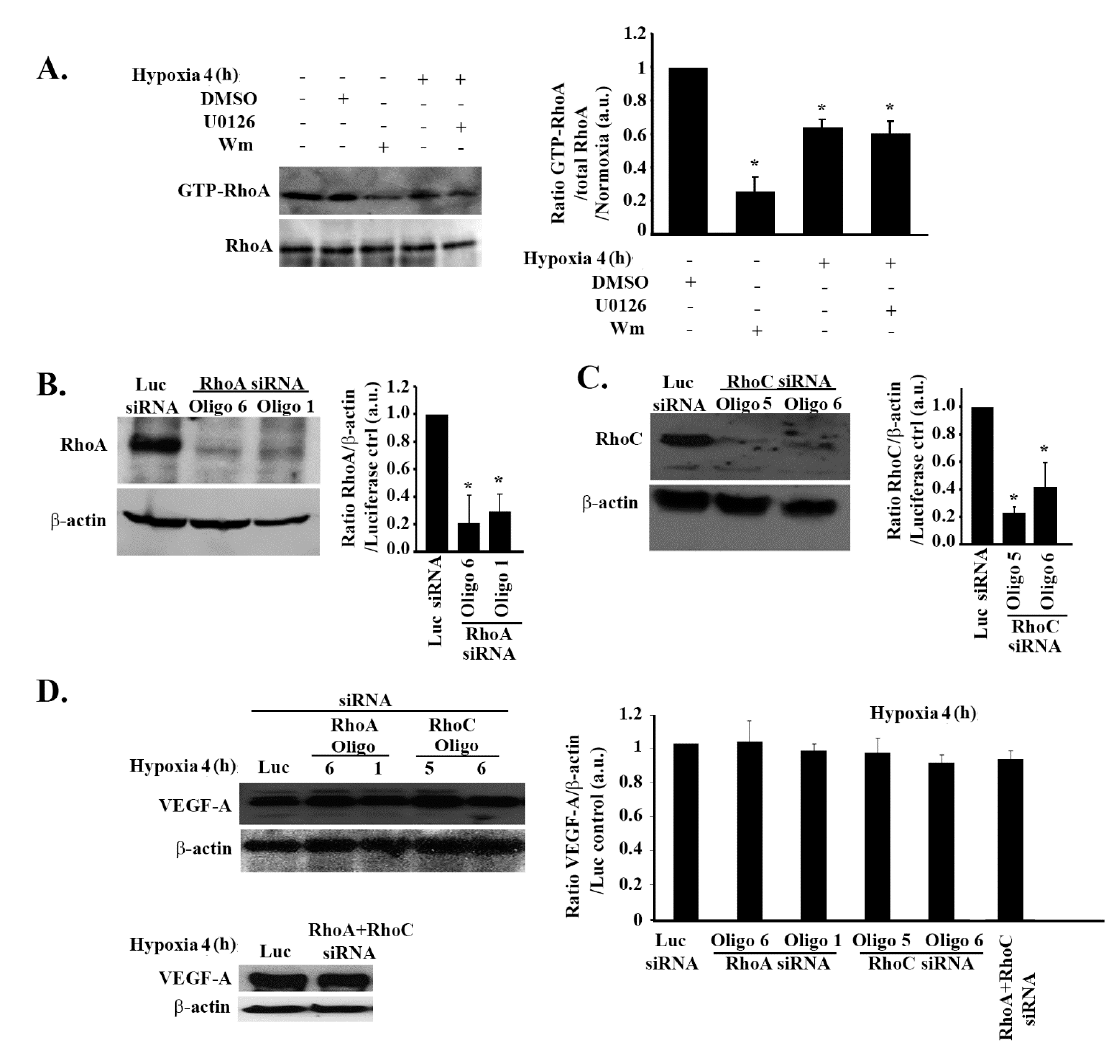
Figure 3. Hypoxia-induced increase in VEGF expression is independent of RhoA and RhoC in glioblastoma cells. ( A ) ( + indicates addition of the treatment) SF-268 cells were treated with DMSO alone or U0126 or Wm, subjected to hypoxia for 4 h, or left in normoxia and lysed. The lysates were then subjected to a RhoA pull-down assay. The upper gel shows the active (GTP-loaded) RhoA that was pulled down with the GST-RBD beads blotted with anti-RhoA, and the lower gel shows the total lysates blotted for anti-RhoA for loading control. The graph is a quantitation of the bands in the upper gel normalized to total RhoA and expressed as fold change compared to time zero (normoxia). (B / C) SF-268 cells were transfected with luciferase siRNA for control of with two RhoA small interfering RNA (siRNA) oligos (oligos 6 and 1) ( B ) or two RhoC siRNA oligos (oligos 5 and 6) ( C ) for 72 h. Cells were then lysed, and cell lysates were blotted for RhoA or β -actin for loading control ( B ) or RhoC and β -actin ( C ). The graphs are quantitations of the bands in (B / C) normalized to actin and expressed as fold change compared to luciferase siRNA control. ( D ) SF-268 cells were transfected with di ff erent siRNA oligos as indicated (or doubly transfected with RhoA and RhoC siRNA for double knock down; lower gel), then subjected to 4 h hypoxia or kept in normoxia. Cells were then lysed, and cell lysates were blotted for VEGF-A or β -actin for loading control. The graphs are quantitations of the VEGF bands normalized to actin and expressed as fold change compared to control (luciferase siRNA). The data are means ± SEM from three different experiments (n = 3); * p < 0.05 indicates statistically significant differences.